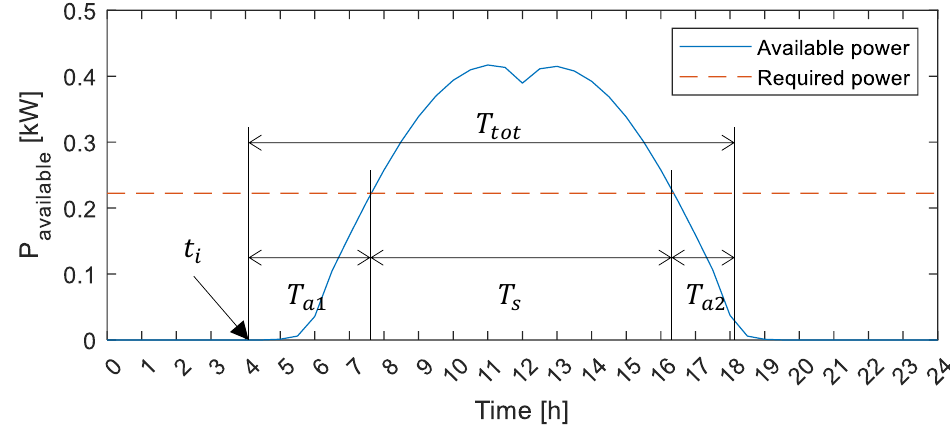
Figure 8. Example of instantaneous total available solar power and required power for flight. In the present study, mission parameters affecting the available power (e.g.,: day of the year, latitude, mission profiles, t i , etc.) as well as the amount of energy available from batteries are given as constant input, therefore the flight endurance only depends on the total power demand, given by the sum of power required for flight ( P req ) and payload and systems power demand. Being this latter among the constant input, the total power demand depends on P req , which is calculated in level flight condition under trim constraint as indicated in Equation (4), Where M is the aircraft mass, g is the gravitational acceleration, V is the airspeed, C L is the lift coefficient and C D is the drag